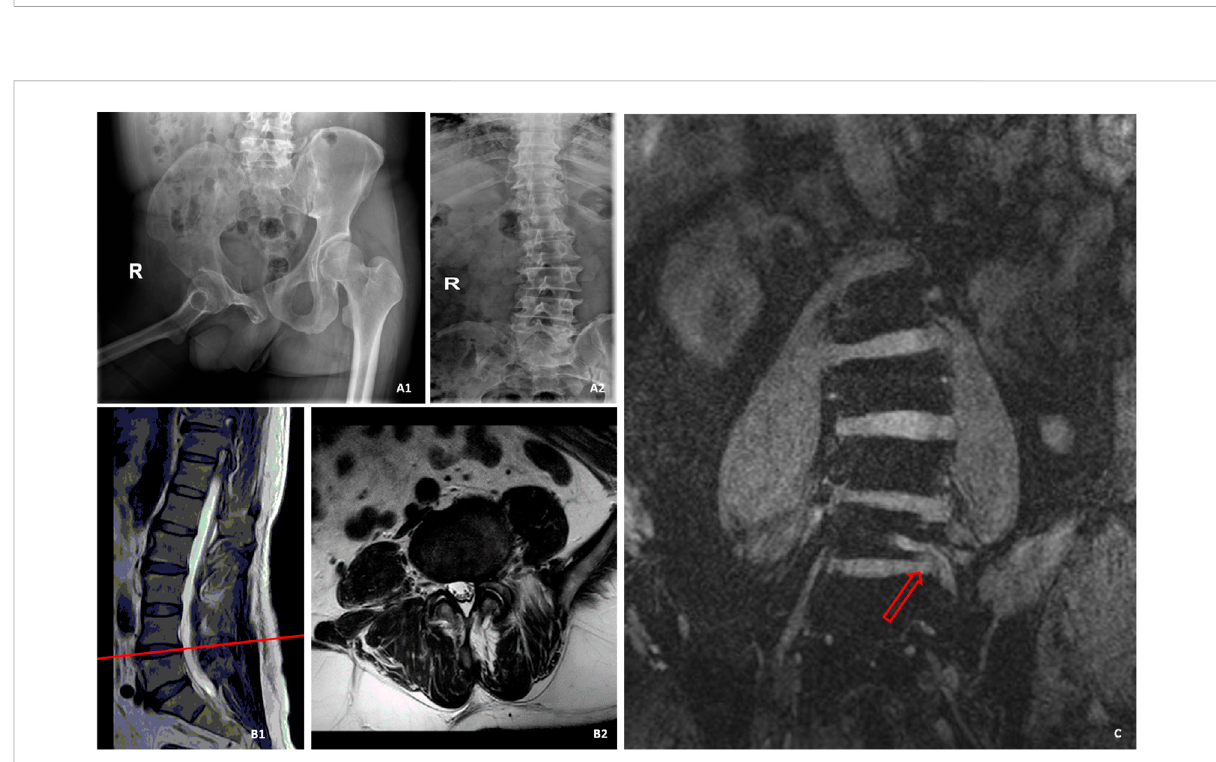
FIGURE 4 Apatientwithspinal deformitycausedbypoliomyelitis,whowasadmittedtohospitalwithLBPandradiationpainofleftlowerlimb. (A1) wasthe pelvic X-ray of the patient. (A2) was the spine radiograph. B was the MR image of the L4/L5 segment of the spine, and no suspicious disc herniation wasfound. (C) wasa3D-DESSimage.Owingtoscoliosis,theleftL5nerverootcouldonlybedisplayedonasingleslice,anditcouldbeobservedthat the left side of L5 nerve root was compressed by a huge nucleus